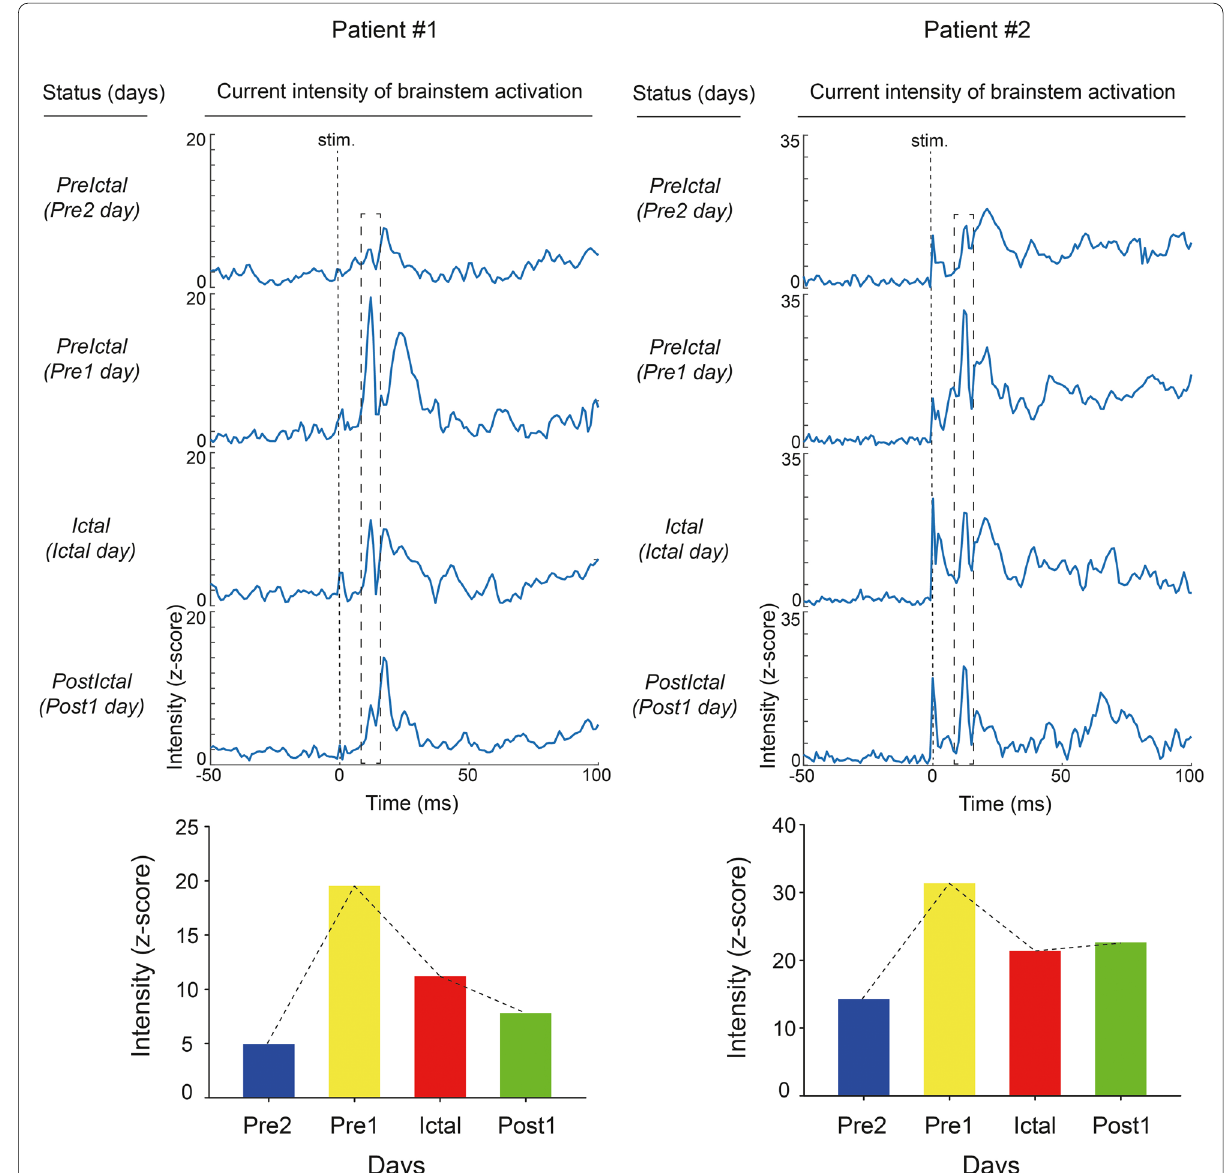
Fig. 3 Evoked brainstem activation during migraine cycle. Top: Brainstem activation over time ( cycle for patient 1 and patient 2. Bottom: Peak brainstem activation during migraine cycle. Pre2 , 24–48 h before headache onset; Pre1 , within 24 h before headache onset; Ictal , during migraine attack; Post1 , within 24 h after headache offset. Stim., stimulus